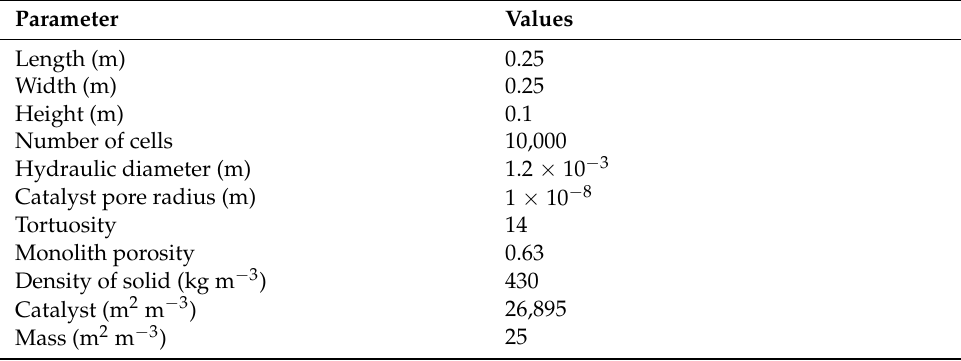
Table 7. Catalytic combustor